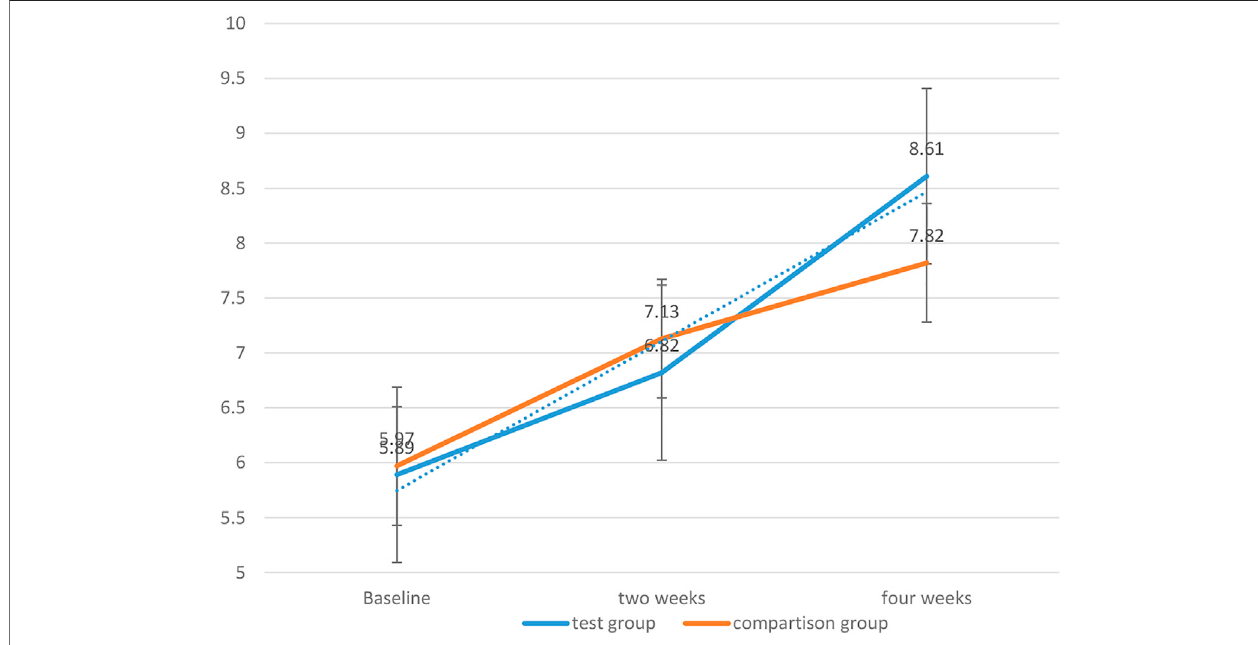
FIGURE 3 | Trends in emergency clinical capabilities.